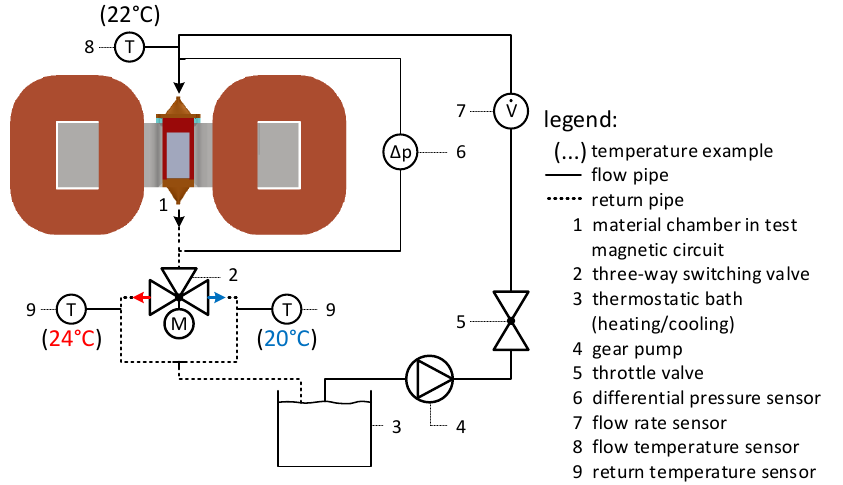
Figure 4. Scheme of the test stand for the investigation of the thermal and hydraulic